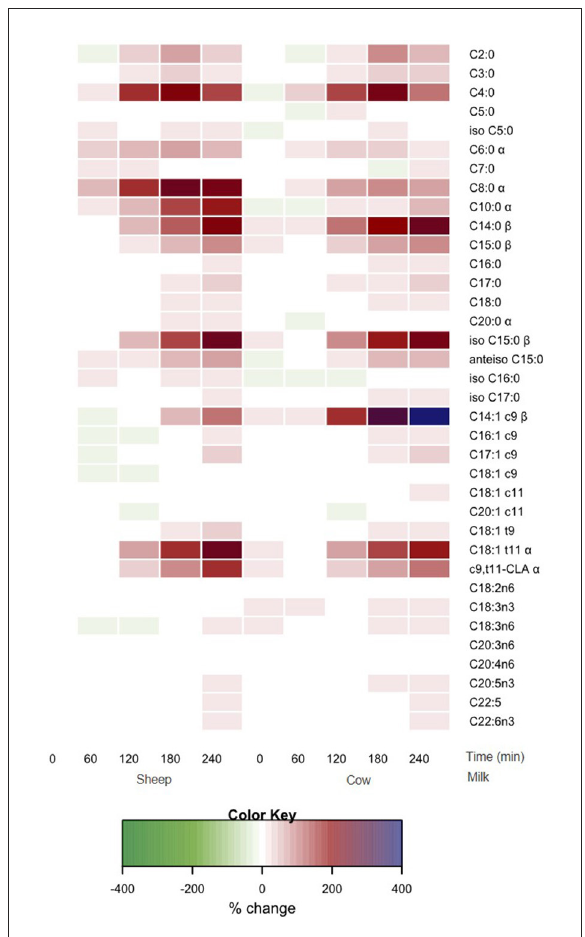
FIGURE4 Heat map of postprandial changes in individual plasma fatty acid after SM and CM ingestion. Values are presented as mean log fold % changes relative to concentrations at fasting SM (0min); white represents a 0% change from SM baseline; red represents a 50% increase; blue represents and 100% increase; green represents a decrease; α denoted interaction time × milk with postprandial SM abundance greater than CM ( p < 0.05), while β denoted postprandial CM abundance is greater than SM ( p < 0.05). SM, sheep milk; CM, cow